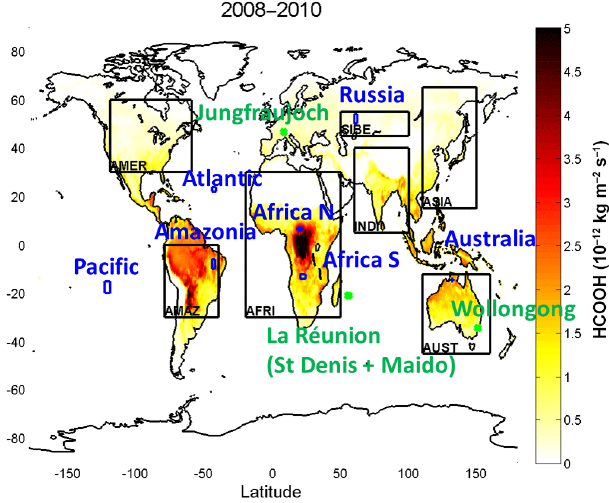
Figure 1. MEGAN-MACC HCOOH emissions for the period be- tween 2008 and 2010 on a 0.5 ◦ × 0.5 ◦ grid. The green stars corre- spond to the location of the FTIR measurements, the seven selected regions used for the retrievals and described in Table 1 are high- lighted in blue, and the black boxes are the regions used for the comparison with